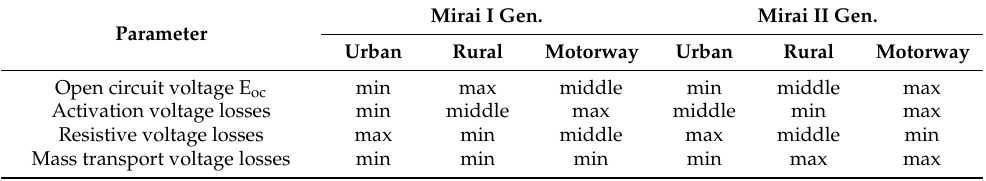
Table 6. Assessment of fuel cell losses taking into account both generations of fuel cell systems.